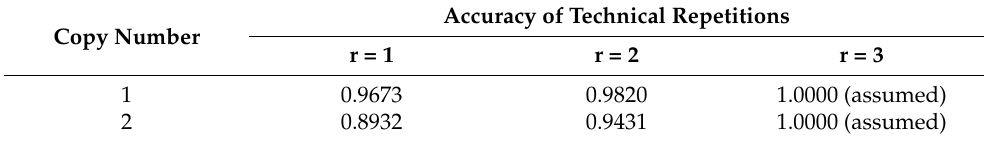
Table 4. Prediction accuracy of different technical repetitions using random sample analysis ( n =